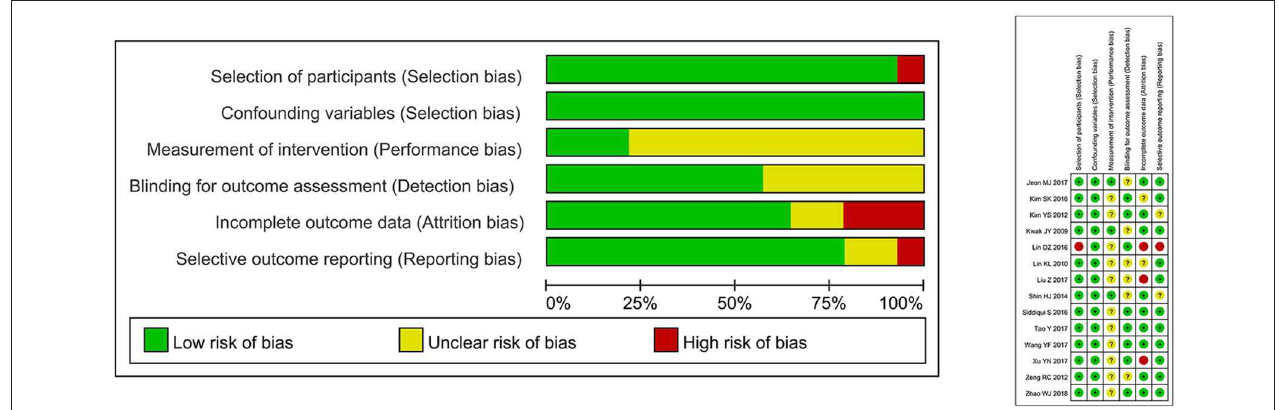
FIGURE 4 | Risk of bias graph: review authors’ judgements about each risk of bias item presented as percentages across all included